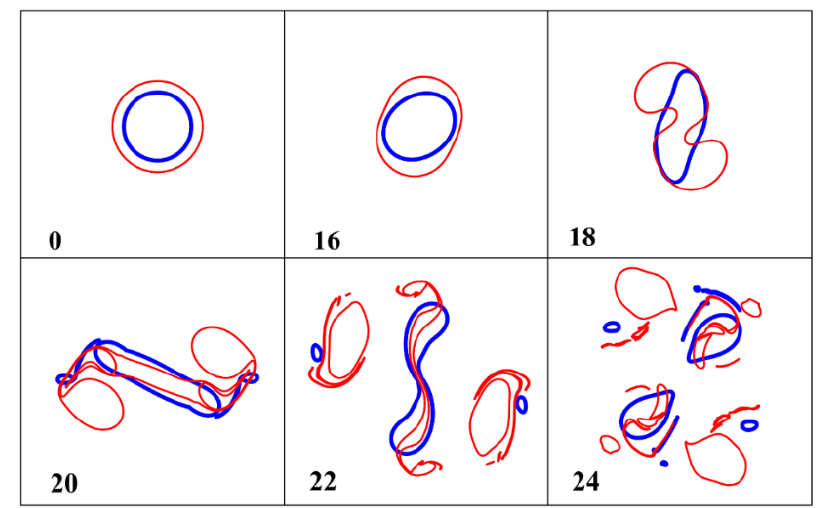
Figure 4. Horizontal projections of the synchronous configurations of the vortex-patch contours of the upper (red) and middle (blue) layers at the dimensionless moments indicated on each subplot, for ( r 1 ; Π 1 ) = ( 4;0.25 ) and ( r 2 ; Π 2 ) = ( 3; − 0.60 ) , i.e., a ratio of “e ff ective” vorticity, P 1 / P 2 = − 0.4444. The round marker in the region of instability in Figure 3 corresponds to this experiment.